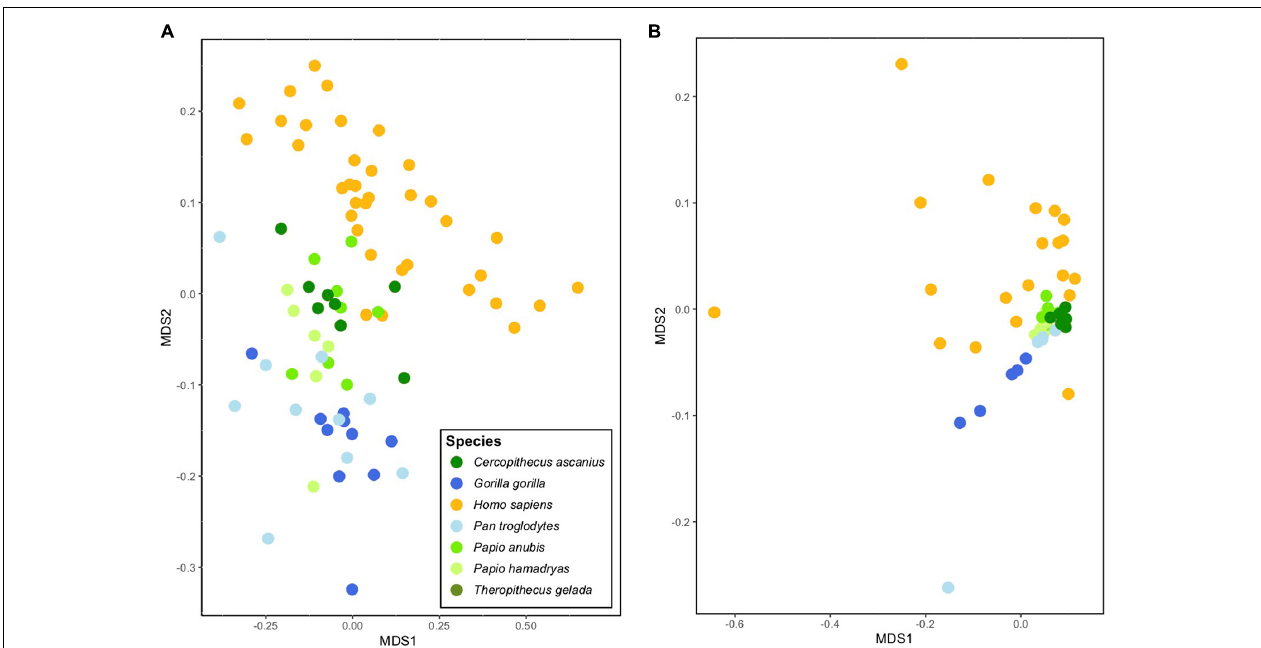
FIGURE 3 | Ordination plot indicating similarities in the gut microbiomes of select primate species based on (A) taxonomic composition and (B) functional potential (data from Amato et al., 2019b). Each point represents the gut microbiome of a single individual, and clustering of points indicates similarity. Note that redtail monkeys ( Cercopithecus ascanius ) and baboons ( Papio anubis and P. hamadryas ) generally cluster closer to humans than do chimpanzees ( Pan troglodytes ) and gorillas ( Gorilla gorilla) in both plots. Note also the relatively higher variation among individual humans (even with the small sample size included here) in functional bacterial genes (scatter of yellow points at